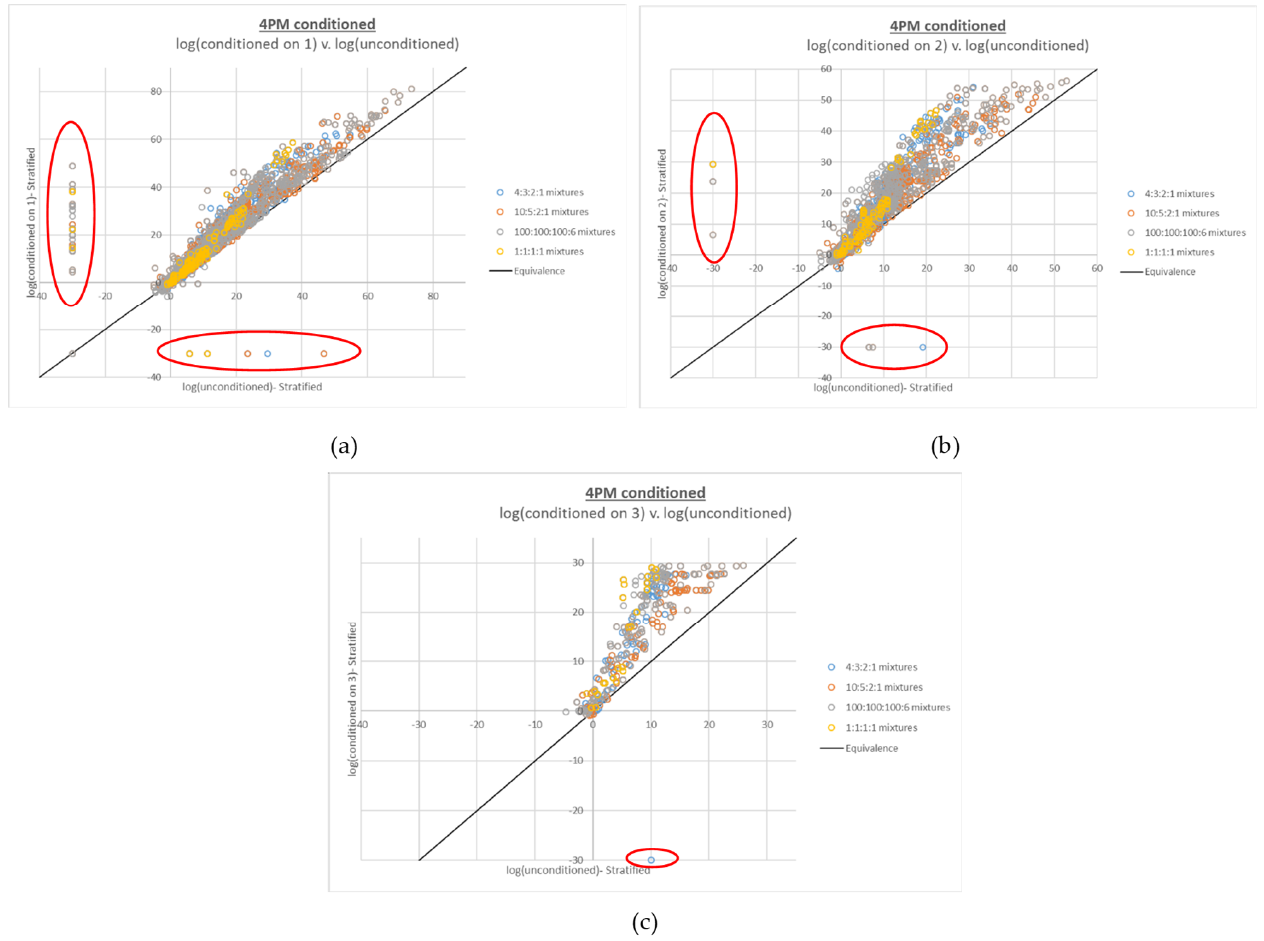
Figure 5. Plots of 4-person log(LR)s based on conditioned interpretations v. corresponding log(LR)s based on unconditioned interpretations run at the default number of MCMC accepts. The number of conditioned true contributors are ( a ) 1, ( b ) 2, and ( c ) 3. False negative LRs (LRs of 0, plotted at −30 and circled in red) are observed along both the X and Y axes for all but the interpretations conditioned on three true contributors ( c ).